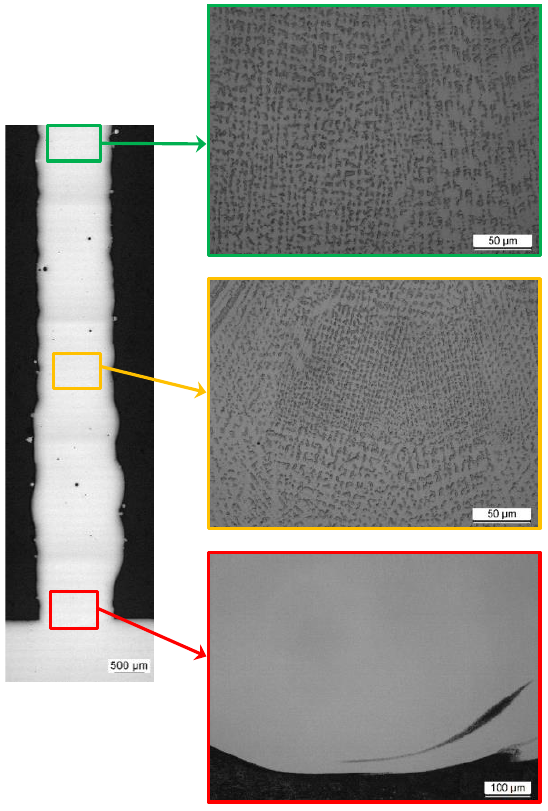
Figure 13. Photomicrographs by LOM of sample 3 (IN718, e = 0.40 and power control) in different areas. Interface with substrate (200X bottom), at 5 mm wall height (500X center) and 10 mm wall height (500X top).